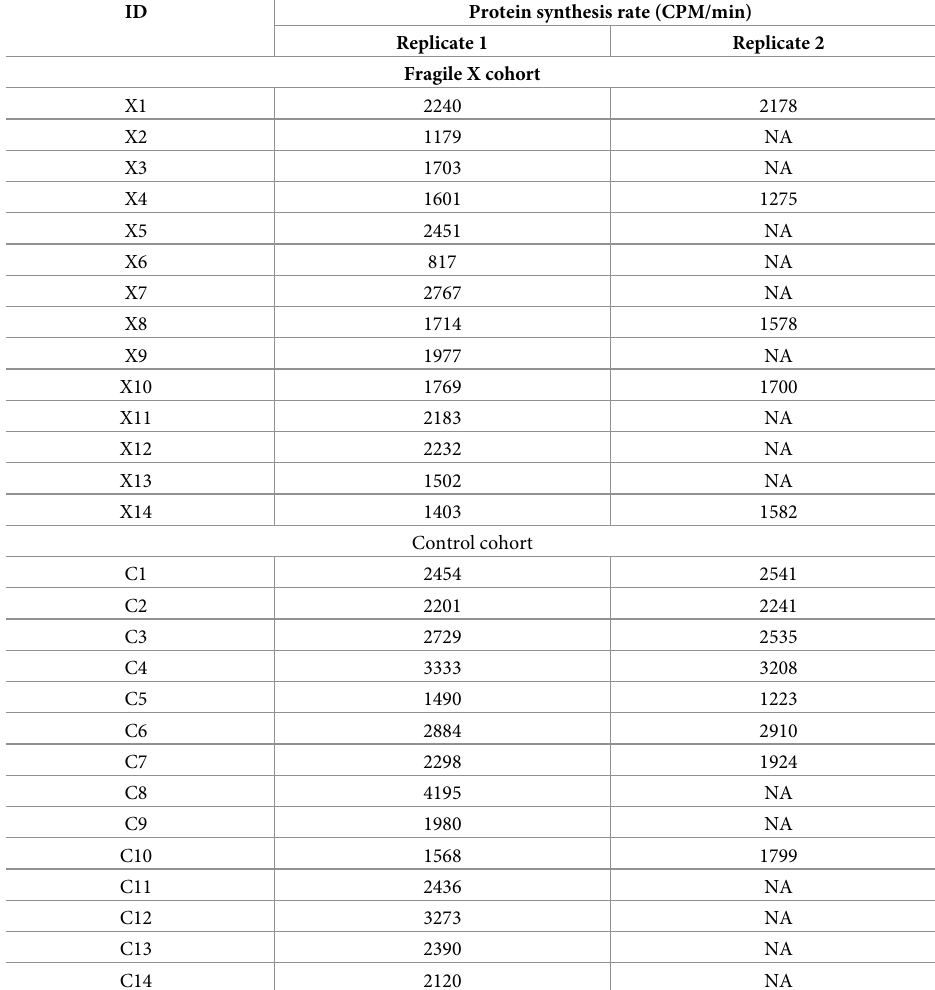
Table 2. Measurements of the rates of protein